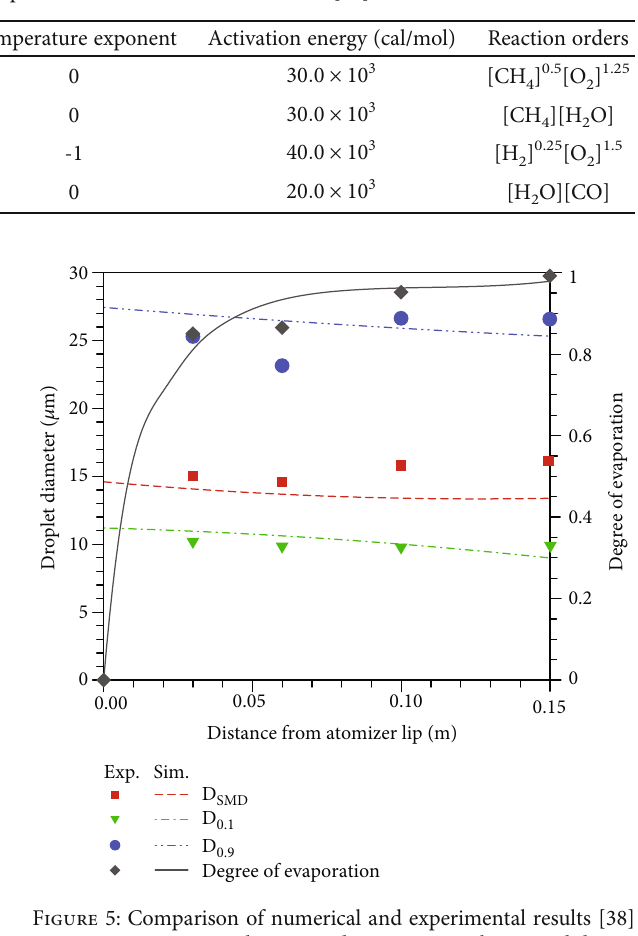
Figure 5: Comparison of numerical and experimental results [38] on representative particle sizes and cross-sectional averaged degree of evaporation.